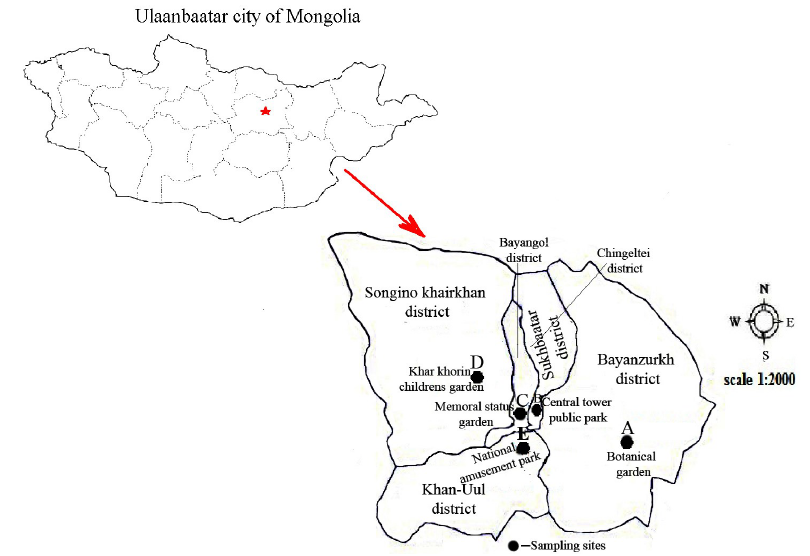
Fig. 1. Locations of soil sampling sites from Ulaanbaatar city